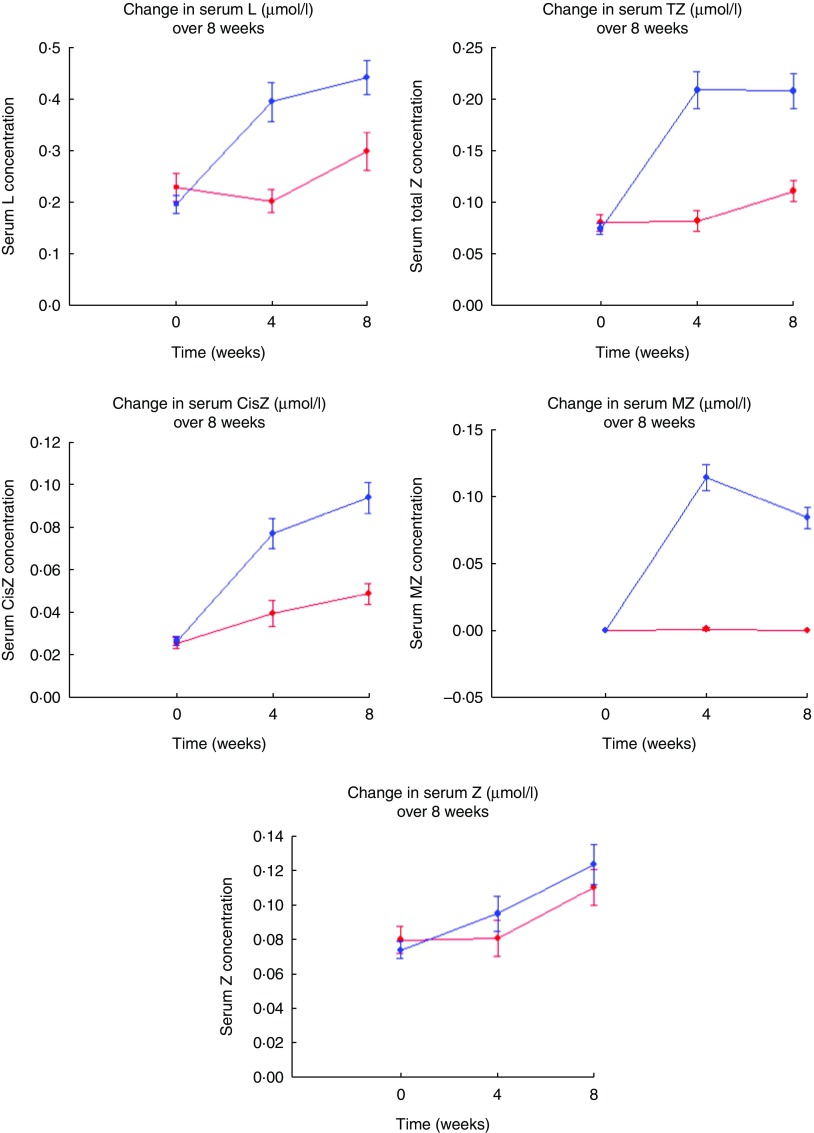
Change in serum concentrations (µmol/l) of lutein (L), total zeaxanthin (TZ),
cis-zeaxanthin (CisZ), meso-zeaxanthin (MZ) and
zeaxanthin (Z) between baseline, midpoint (4 weeks) and final visit (8 weeks) using
both reversed phase HPLC for L, TZ and CisZ analysis, and normal phase HPLC for Z:MZ
ratio analysis on an Agilent 1260 Series system (Agilent Technologies Limited) in
the Egg Xanthophyll Intervention Trial; control egg group subjects ();
one standard egg per day. Enriched egg group subjects ();
one L:MZ enriched egg per day. Increases in serum carotenoid levels can be seen at
midpoint and final visits in the enriched egg group relative to the control group
for L, TZ, CisZ and MZ, which are reflected in the higher concentration values seen.
Increases in serum Z levels can be seen at midpoint in the enriched egg group
relative to the control group, which are reflected in the higher concentration
values seen. However, concentrations of Z were not significantly different between
groups at final visit, reflected in the similarity of serum Z concentrations in both
groups. Values are means, with their standard errors.